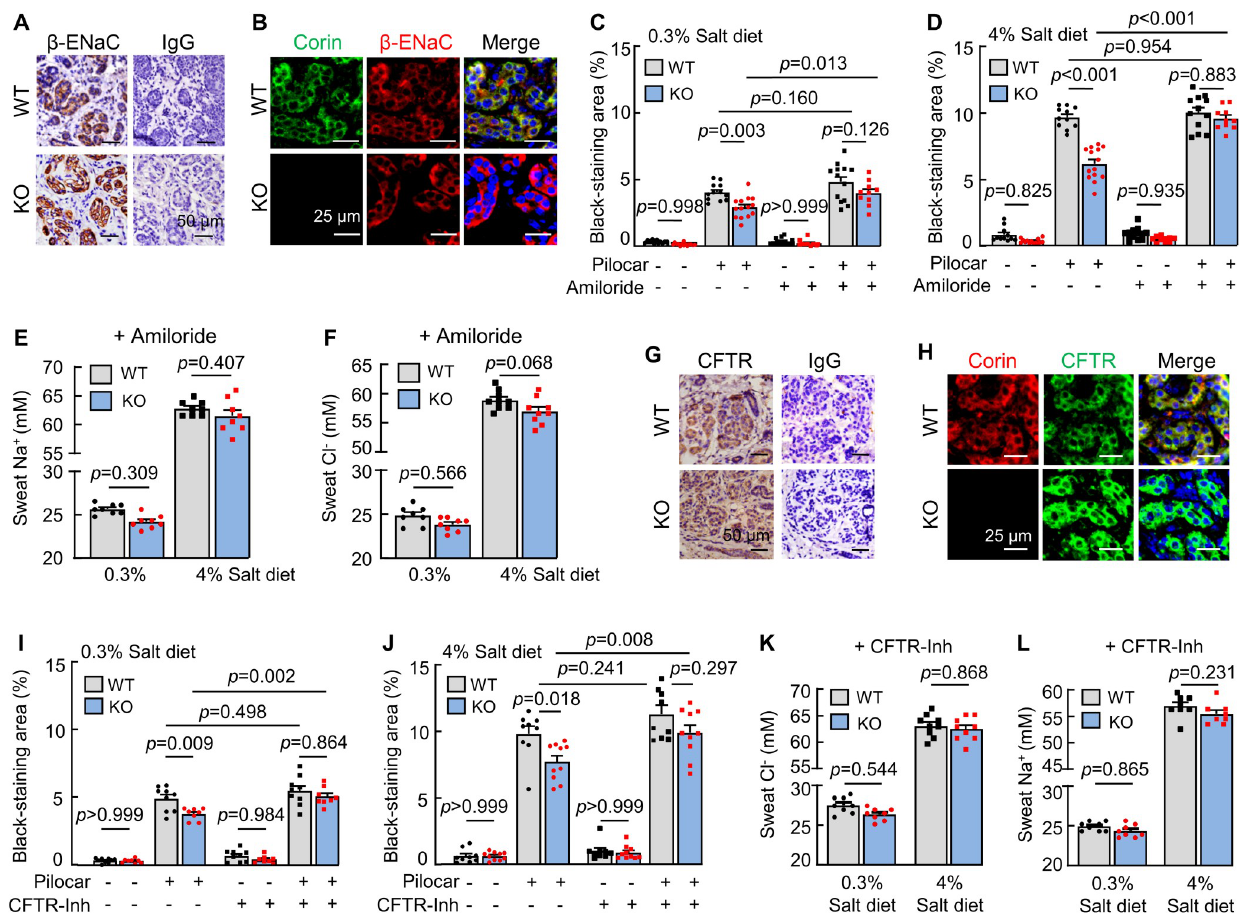
Fig 3. Effects of ENaC and CFTR inhibitors on sweat excretion. (A) Immune staining of β -ENaC (brown) in eccrine sweat glands from WT and corin KO mouse footpads. IgG was a negative control. (B) Co-staining of corin (green) and β -ENaC (red) in WT and corin KO eccrine sweat glands. (C and D) Sweat excretion, indicated by black-staining areas, was measured in WT and corin KO mice on 0.3% (C) or 4% (D) salt diet, with (+) or without ( − ) amiloride treatment, before ( − ) and 2 min after (+) pilocarpine (pilocar) injection. (E and F) Sweat Na + (E) and Cl − (F) levels in WT and corin KO mice on 0.3% or 4% salt diet and treated with amiloride. (G) Immune staining of CFTR (brown) in eccrine sweat glands in WT and corin KO mouse footpads. (H) Co-staining of corin (red) and CFTR (green) in eccrine sweat glands in WT and corin KO mouse footpads. (I and J) Sweat excretion, indicated by black- staining areas, was measured in WT and corin KO mice on 0.3% (I) or 4% (J) salt diet, with (+) or without ( − ) CFTR(inh)-172 (CFTR-Inh) treatment, before ( − ) and 2 min after (+) pilocarpine (pilocar) injection. (K and L) Sweat Cl − (K) and Na + (L) levels in WT and corin KO mice on 0.3% or 4% salt diet and treated with (+) CFTR-Inh. In bar graphs, data are mean ± SEM. Each dot represents data from 1 mouse, except for sweat Na + and Cl − data, in which each dot represents data from 8 paws of 2 mice. P values were analyzed by 1-way ANOVA, and the original numerical values are in S1 Data. CFTR, cystic fibrosis transmembrane conductance regulator; ENaC, epithelial sodium channel; IgG, immunoglobulin G; KO, knockout; WT, wild-type.